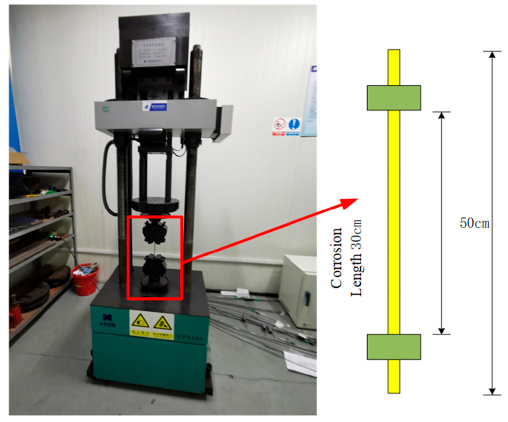
Figure 1. Area diagram of corroded steel wire.